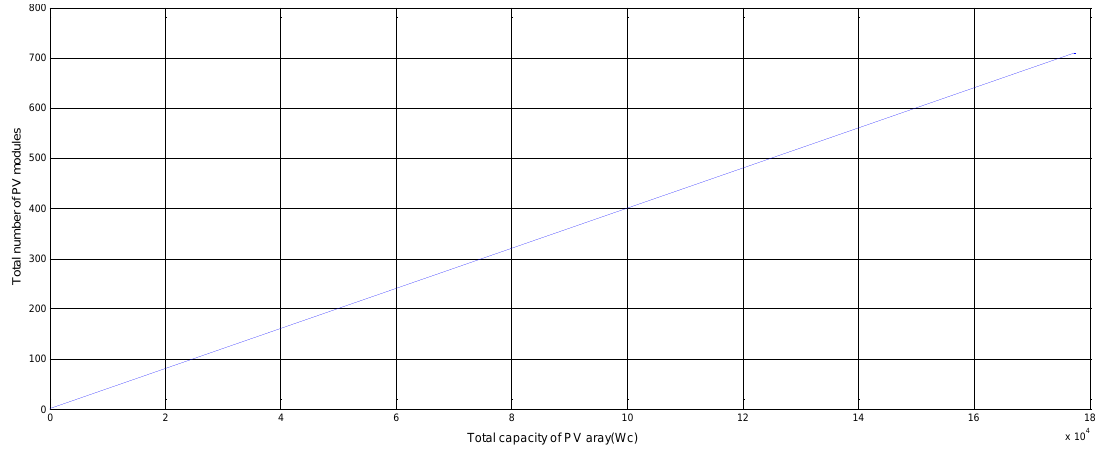
Figure 6 . Variation of total PV number versus total PV capacity obtained with the intuitive